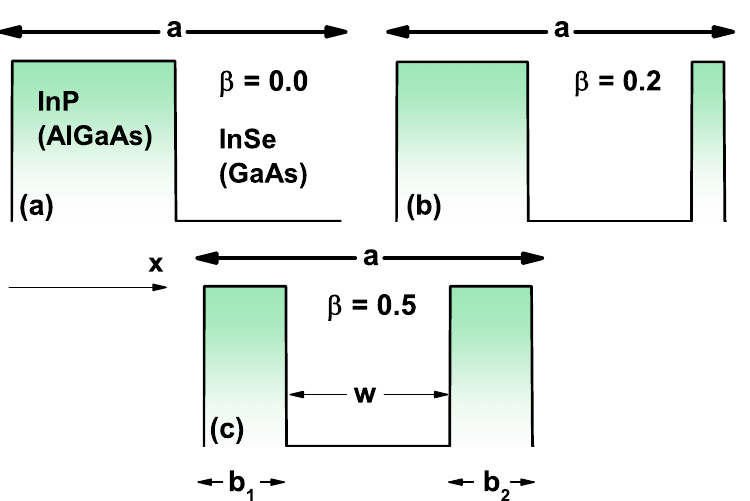
Figure 1. ( a – c ) Scheme corresponding to a single period of the superlattice for β = 0.0, β = 0.2, and β = 0.5, respectively. These parameters are entered in Equations (1) and (2) and Table 1. From the above explanations, it is possible to write expressions for the barrier and well widths in terms of the γ , β , and a parameters,